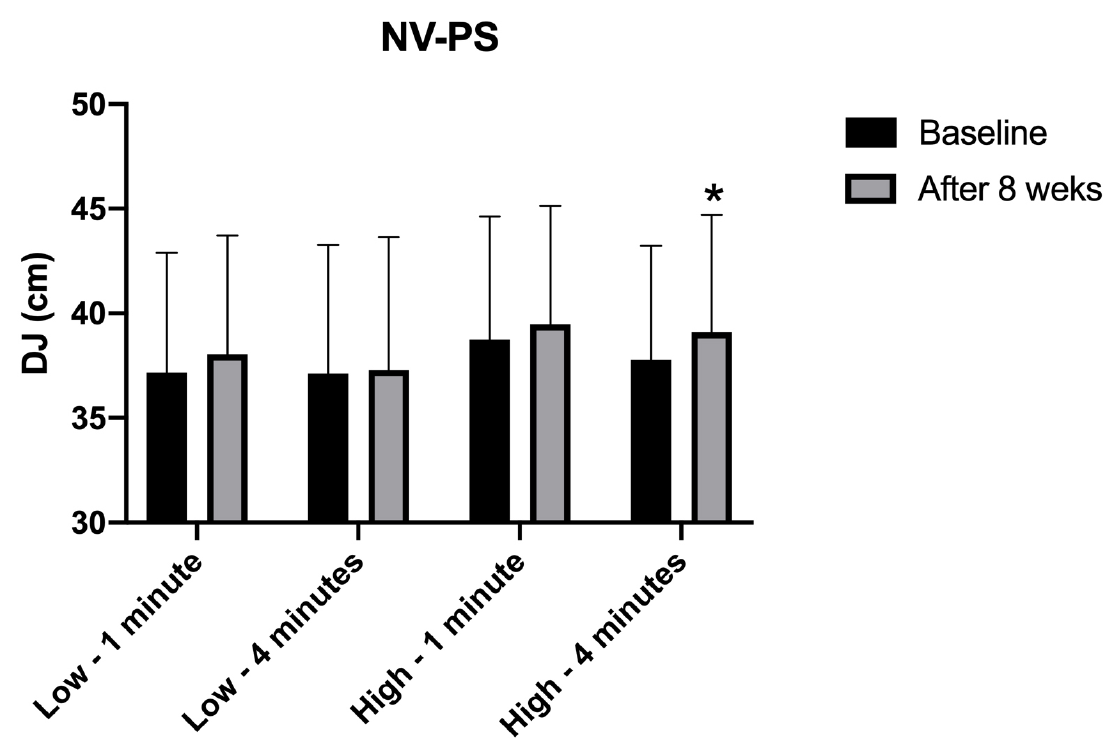
FIGURE 4. Differences between baseline and after post-activation potentiation protocols in terms of volume and rest duration for drop jump (DJ) in parallel squat without vibration (NV-PS). * Significant differences ( p < 0.05) when comparing post-protocol results with